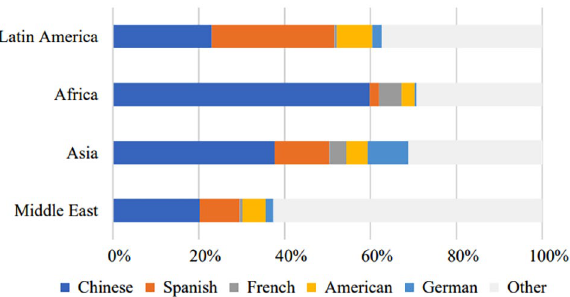
Figure 1. International revenue and market share of Engineering News-Record (ENR) top 5 international contractors